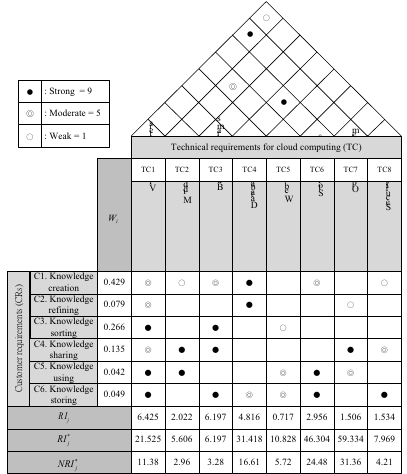
Fig. 4 QFD matrix for a cloud computing selection